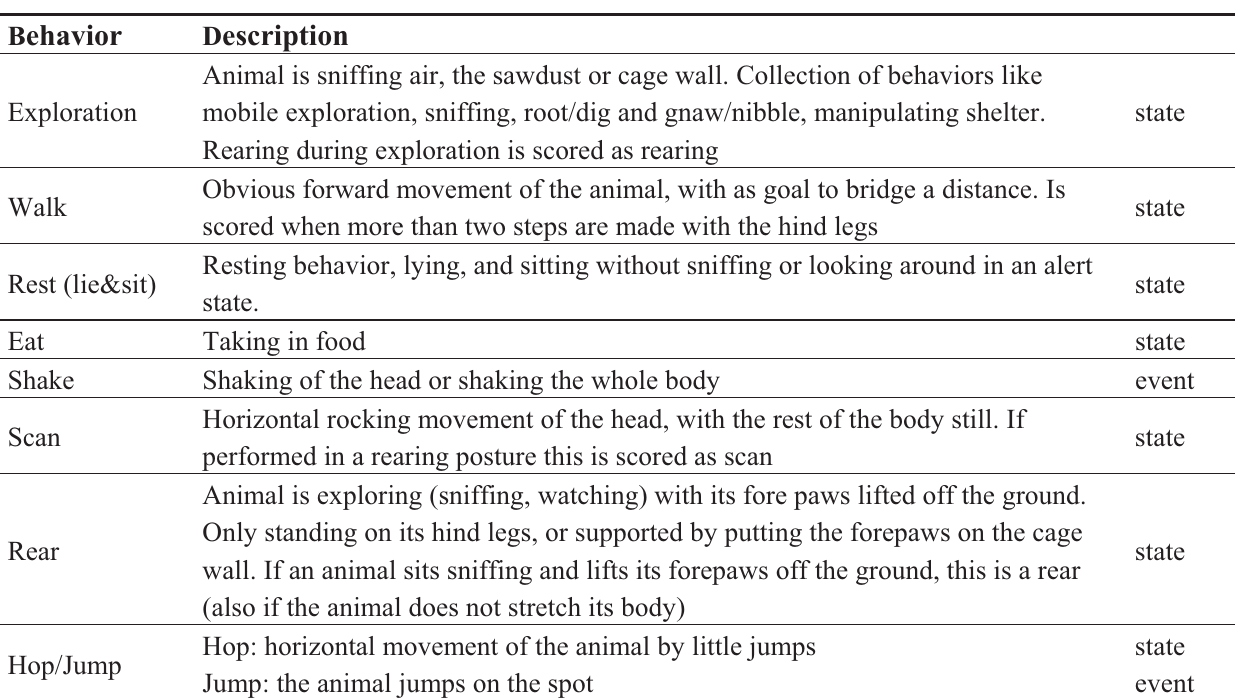
Table A1. Details of ethogram